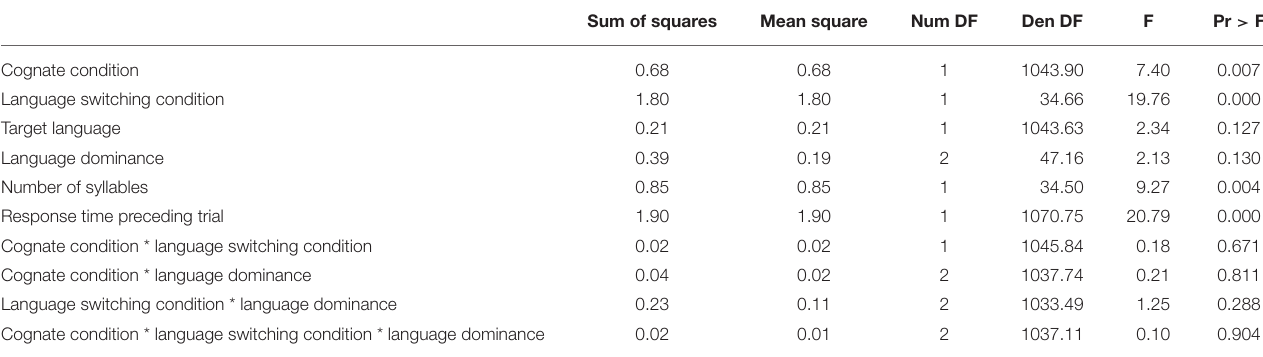
TABLE 4 | Results of the best-fitting linear mixed effects model predicting log response times for fillers. Sum of squares Mean square Num